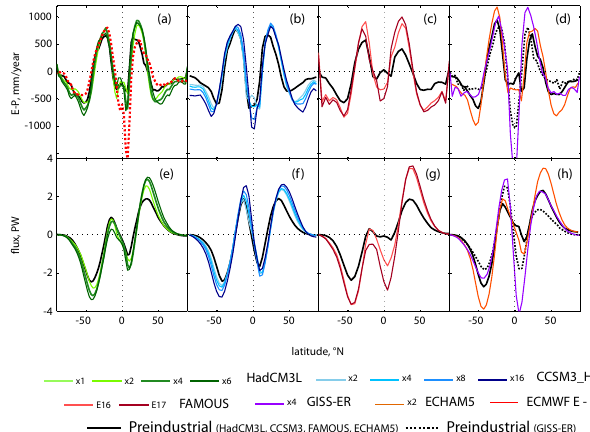
Figure 9. Latitudinal E − P distributions (top) and implied northwards latent heat flux (bottom) in the EoMIP simulations. The black lines indicate preindustrial simulations, with dotted and unbroken lines in (d, h) corresponding to the GISS-ER and ECHAM5 simulations respectively. Heat flux expressed in petawatts (1PW = 1015W). Observational E − P in (a) is based on European Centre for Medium-range Weather Forecasts (ECMWF) European Reanalysis (ERA) data (Dee et al., 2011).